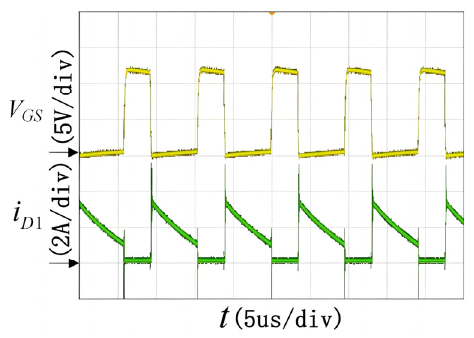
Figure 10. Waveforms of V GS and i D 1 .